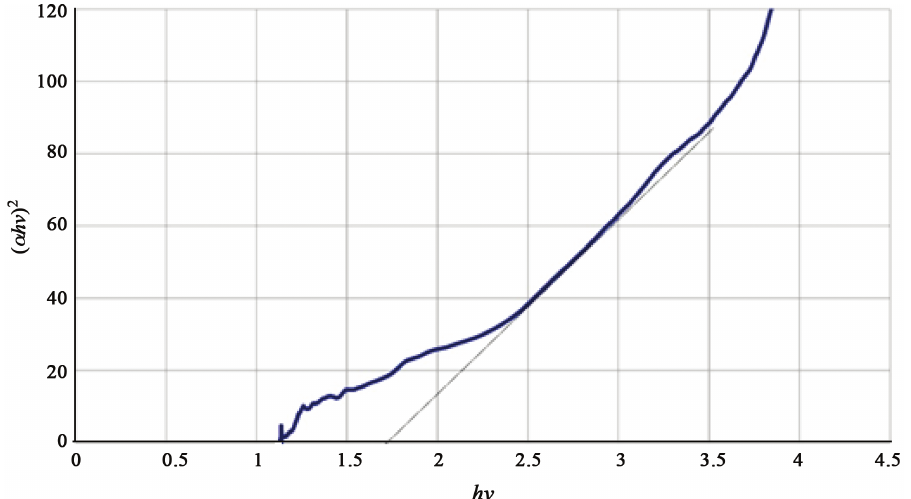
Colorimetric coordinates (L*.a*.b*) The band gap, E , and absorption coefficient of a semi- g conductor are related to Tauc model [29]. In general, for direct band gap determination, plot of ( α h ν ) 2 versus h ν The most frequently used modern system is the CIE ( L * a * b *) is linear at higher values of ( h ν ) 2 , but tends to deviate space which provides an effective means for visualizing from linearity as h ν approaches a lower value. Band color: the L * – axis represents lightness-darkness (ranging gap value was obtained by extrapolating the straight from 0 to 100), the a * – axis redness-greenness, and the b * portion of the graph, as indicated by solid line. The axis yellowness-blueness. The color parameters ( L *. a *. b *) optical absorption curve of NiCr O nanoparticles 2 4 obtained from raw data ’ s of DRS results is shown in Figure 6. The optical absorption curve has been mea- sured and the absorption edge shows that the band gap of NiCr O is about 1.7 eV; hence, NiCr O nanoparticles 2 4 2 4 are semiconductor material applicable for photoelectric devices. The L *. a *. b * color parameters of NiCr